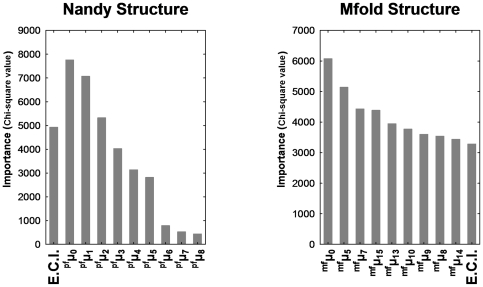
Predictor importance according the variable screening analysis for the Nandy and Mfold structures.E.C.I. (Edege Connectivity Index).